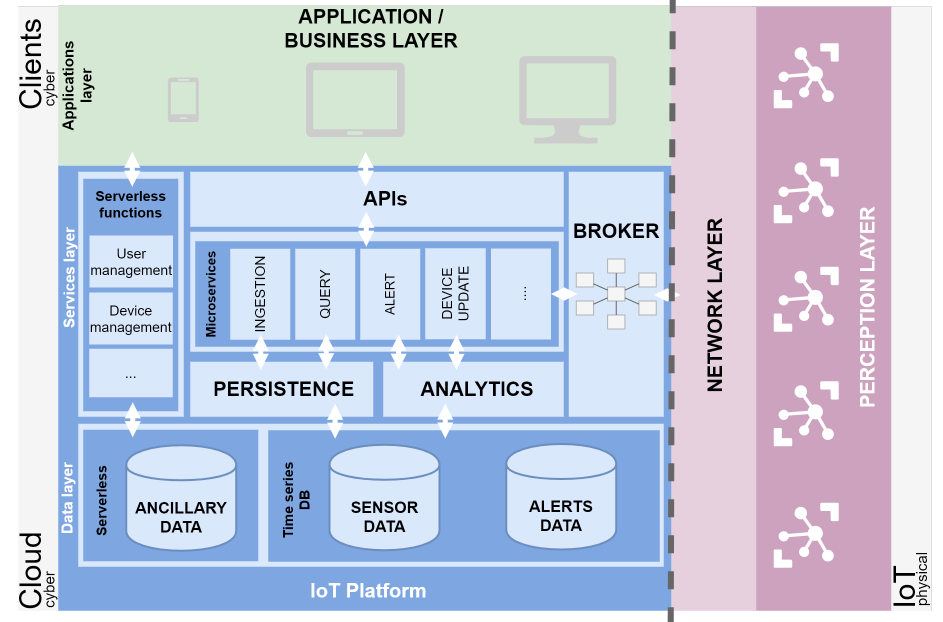
Figure 3. An agnostic-technology IoT